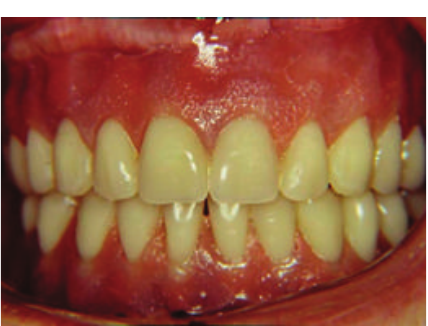
Figure 6: Installation of the new complete denture set after the adaptation of OVD of